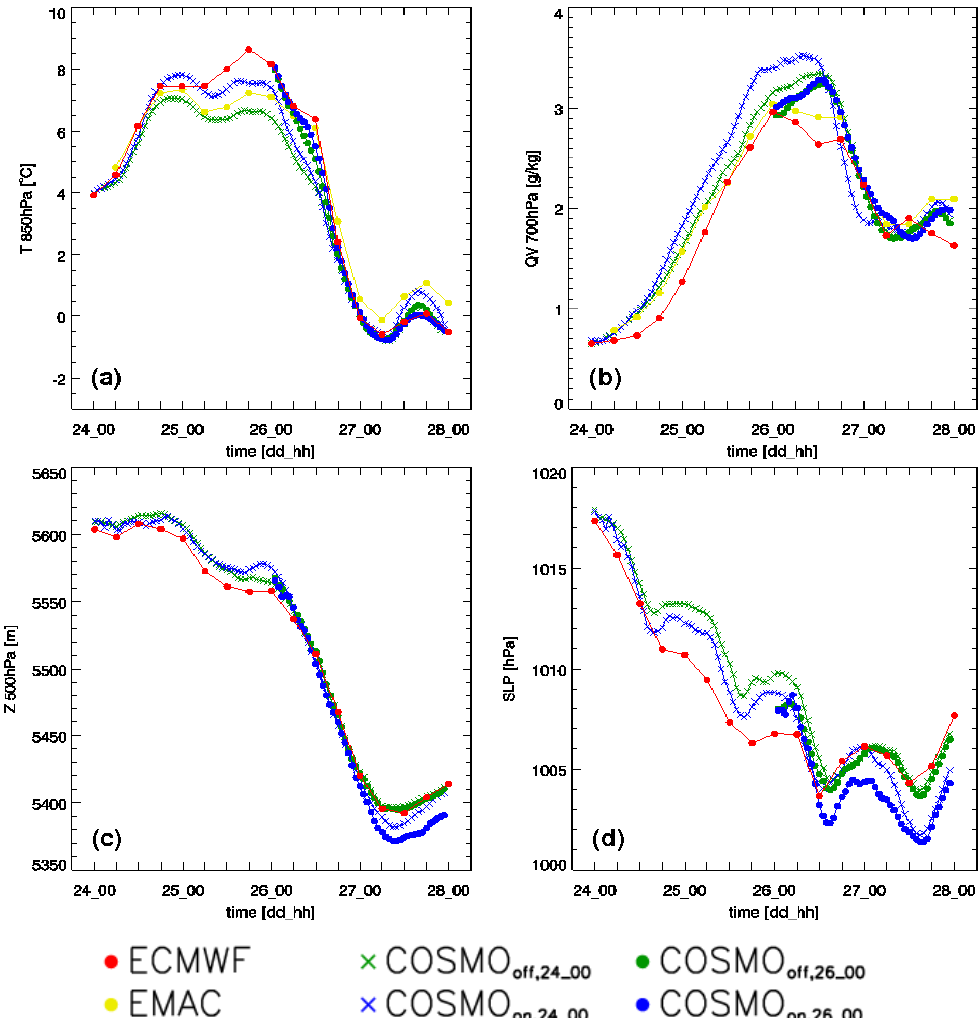
Fig. 4. Time series of typical meteorological parameters averaged in the area of Germany for the frontal case from 00:00 UTC 24 March to 00:00 UTC 28 March 2010. Shown are (a) temperature ( T , in ◦ C) at 850 hPa, (b) specific humidity (QV, in g kg − 1 ) at 700 hPa, (c) geopo- tential height ( Z , in m) at 500 hPa and (c) sea level pressure (SLP, in hPa). Because the output of Z and SLP is not available for EMAC, time series of these variables are not shown for EMAC in panels (c) and (d) .